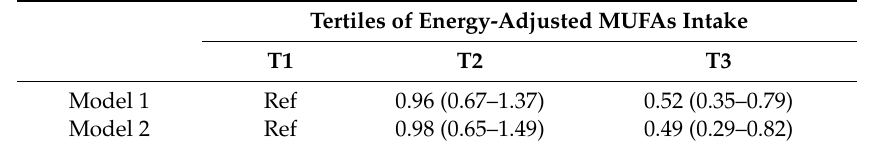
Table 2. Association (OR and 95% CI) for new-onset hypertension according to MUFAs intake by tertiles.